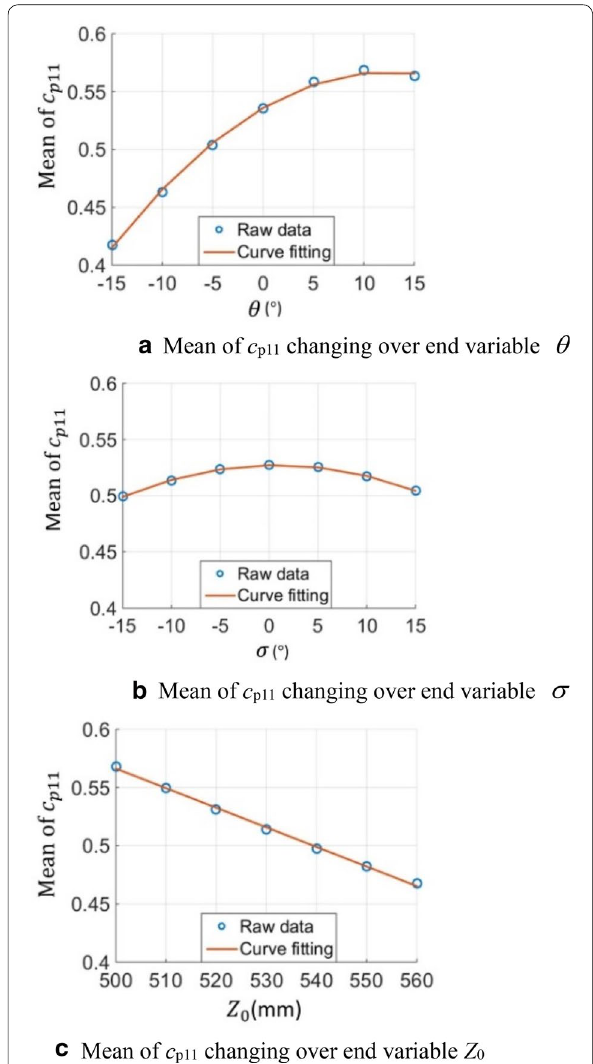
Figure 5 The tendency of correction coefficient c